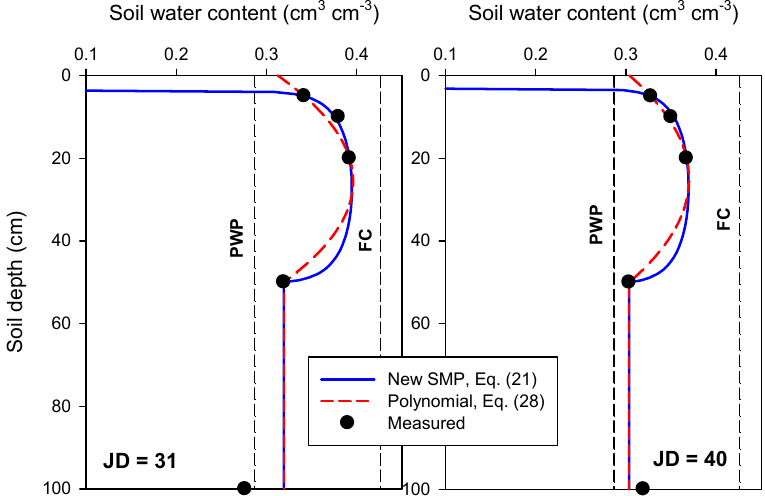
Figure 4. Comparison of Equations (21) (new solution) and Equation (28) (second order polynomial) with measured soil moisture data from Soil Climate Analysis Network (SCAN) site number 2078 (Madison, Alabama) at Julian days (JD) 31 and 40, 2013. The clay soil parameters, P = 15.9 and h cM = 350 cm, were used in Equation (21). PWP: permanent wilting point; SMP: soil moisture profile.